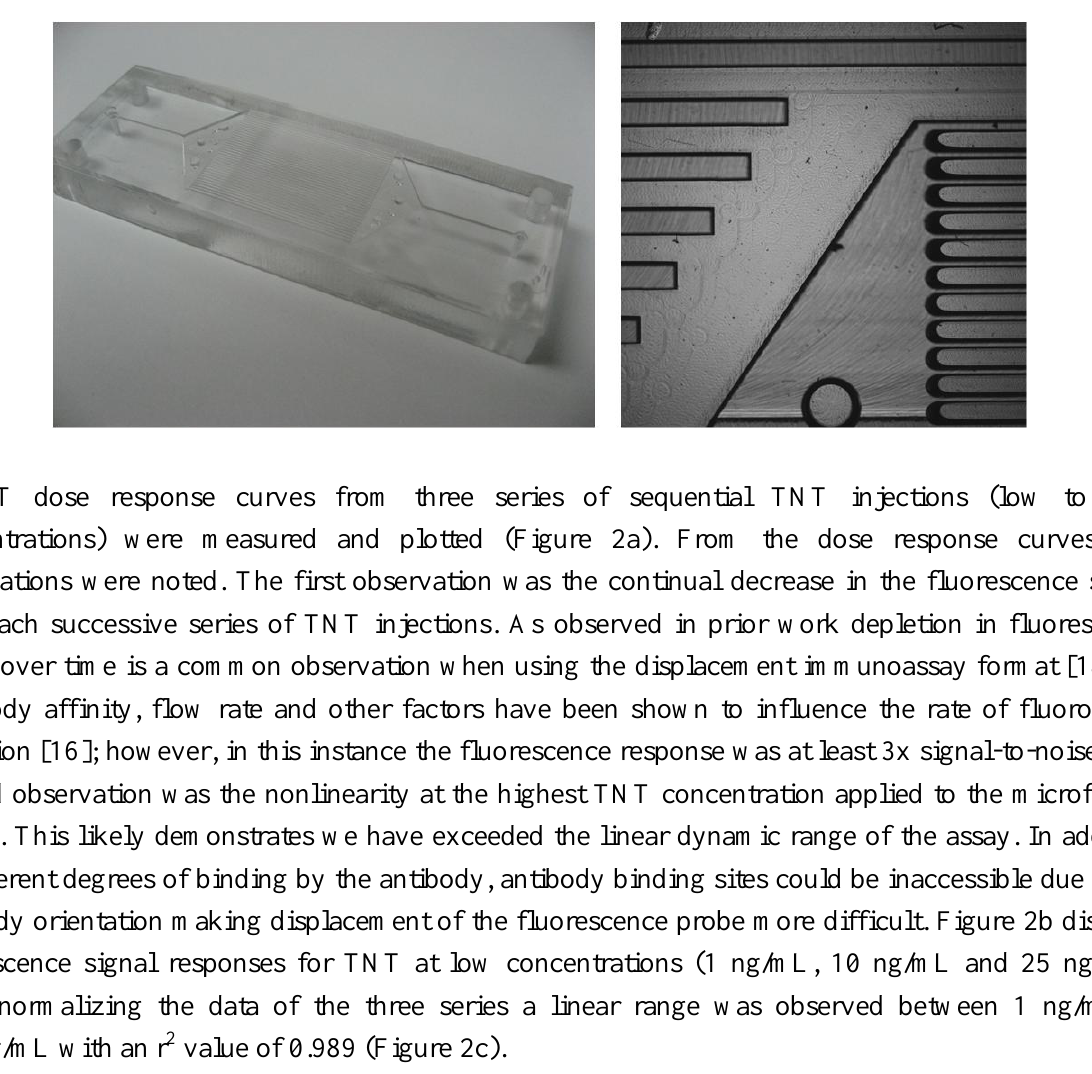
Figure 1. Multi-channel PMMA microfluidic device. (Left) The microfluidic device consisted of a hot-embossed 9 mm thick PMMA substrate that was tri-solvent bonded to a 1.0 mm thick PMMA coverslip. The footprint of the microfluidic device is 76 × 25 × 25 mm. The microfluidic device features flat-bottom 1.0 mm through holes at the inlet and outlet ports for fluid processing. (Right) Brightfield micrograph taken a 2x magnification of the hot-embossed substrate used to assemble the microfluidic